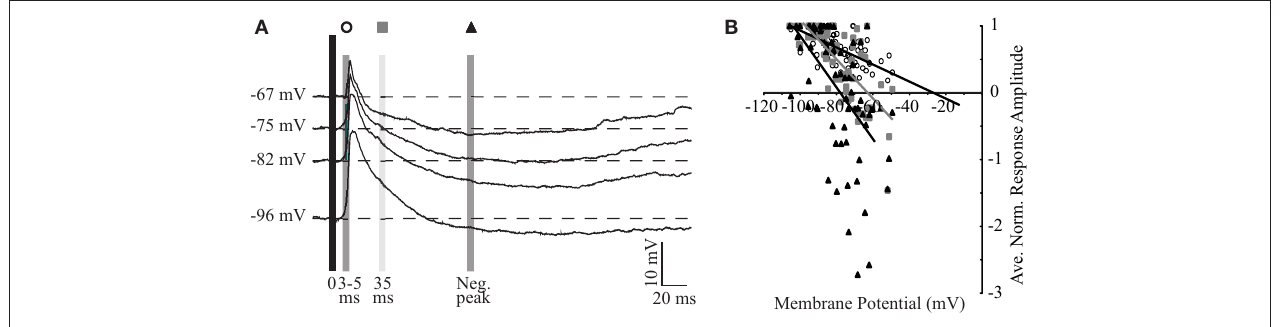
FIgure 3 | Basolateral amygdala stimulation evokes excitatory and inhibitory responses. (A) Averaged PSP of a representative neuron in response to BLA stimulation at different holding potentials. The three shaded boxes indicate the latencies post-PSP-onset at which the reversal potential was computed: empty circle,